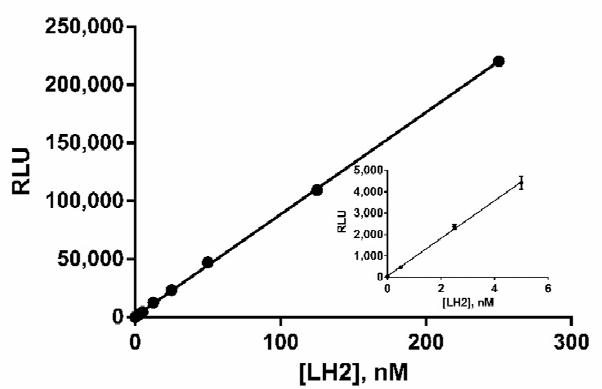
Figure 3. Luminescence (RLU) of PLG2 as a linear function of LH 2 concentration in the presence of 2.5% DMSO. All points are expressed as mean ± SD.